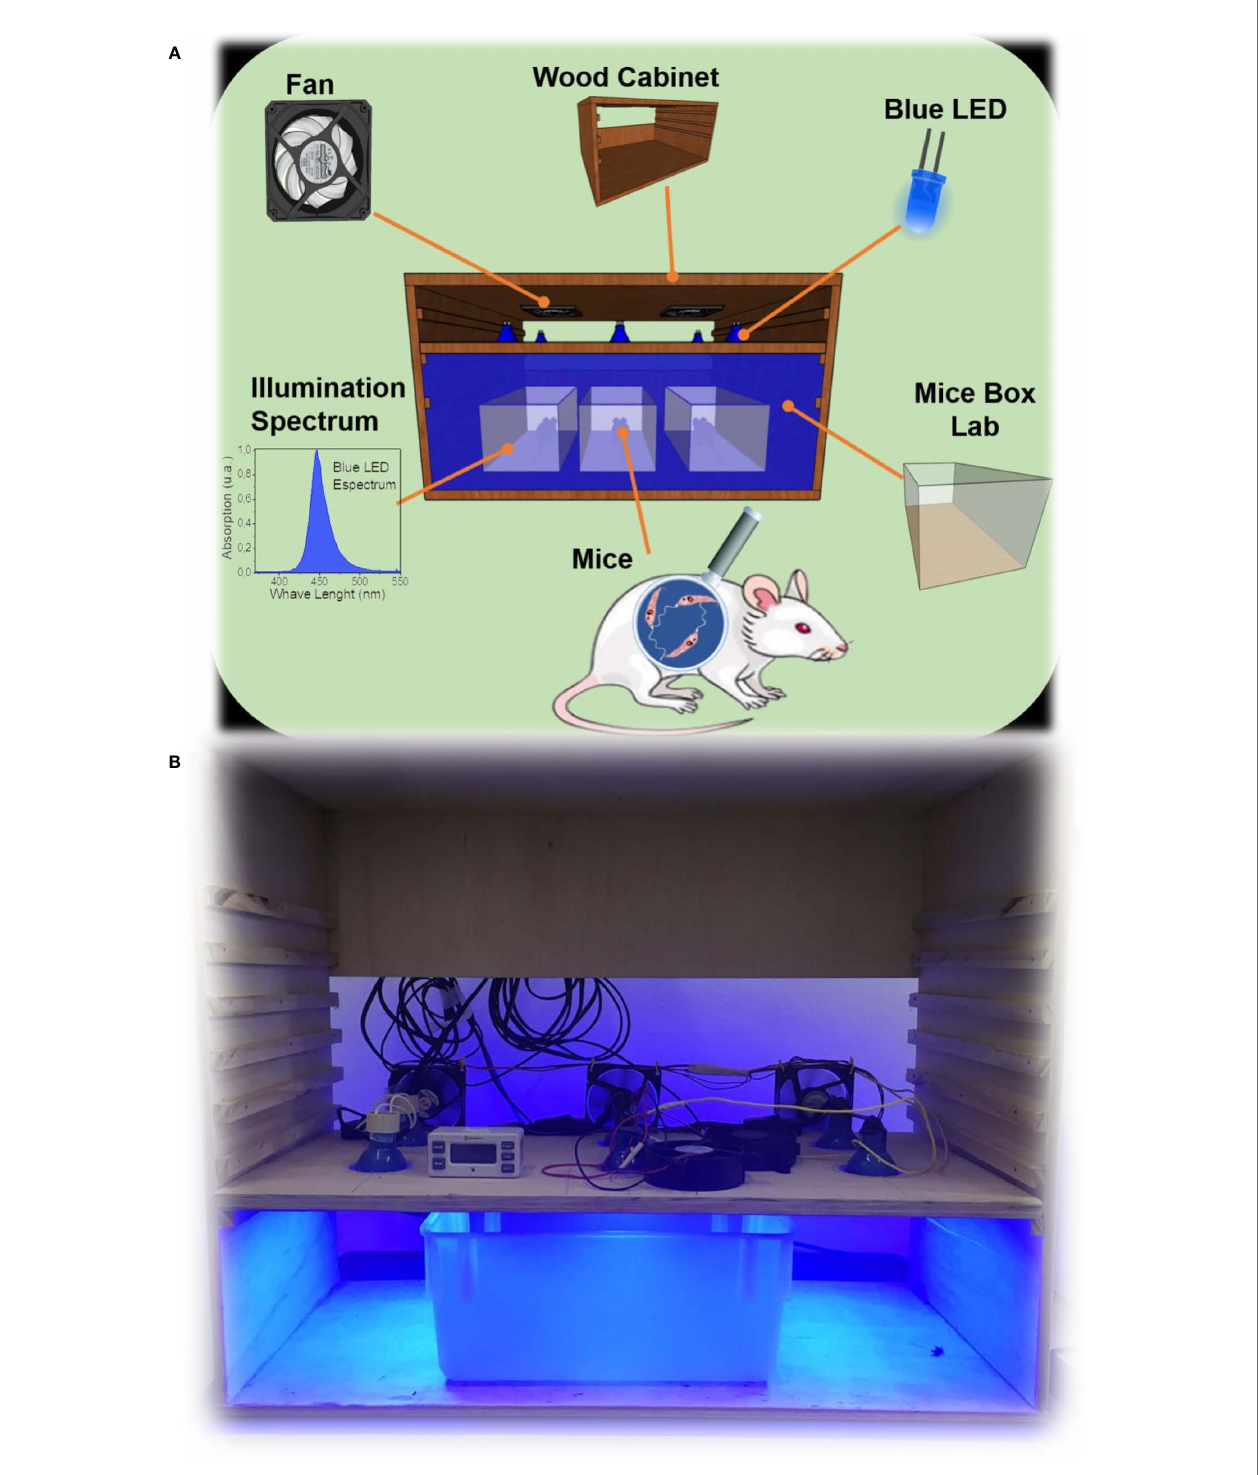
FIGURE 1 | (A) Schematic illustration of homebuilt system for the blue-light phototherapy. Mice were infected with Y strain of T. cruzi and exposed to 460 nm and 7 µW/cm 2 of blue light for 9 days (12h/day). A fan was used to maintain a constant temperature in the mice box. (B) A photo of this robust system is inserted in the fi